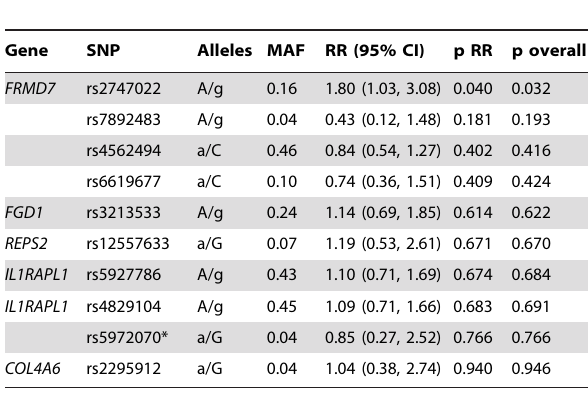
Table 7. Replication of maternal SNPs in the US and Denmark study.